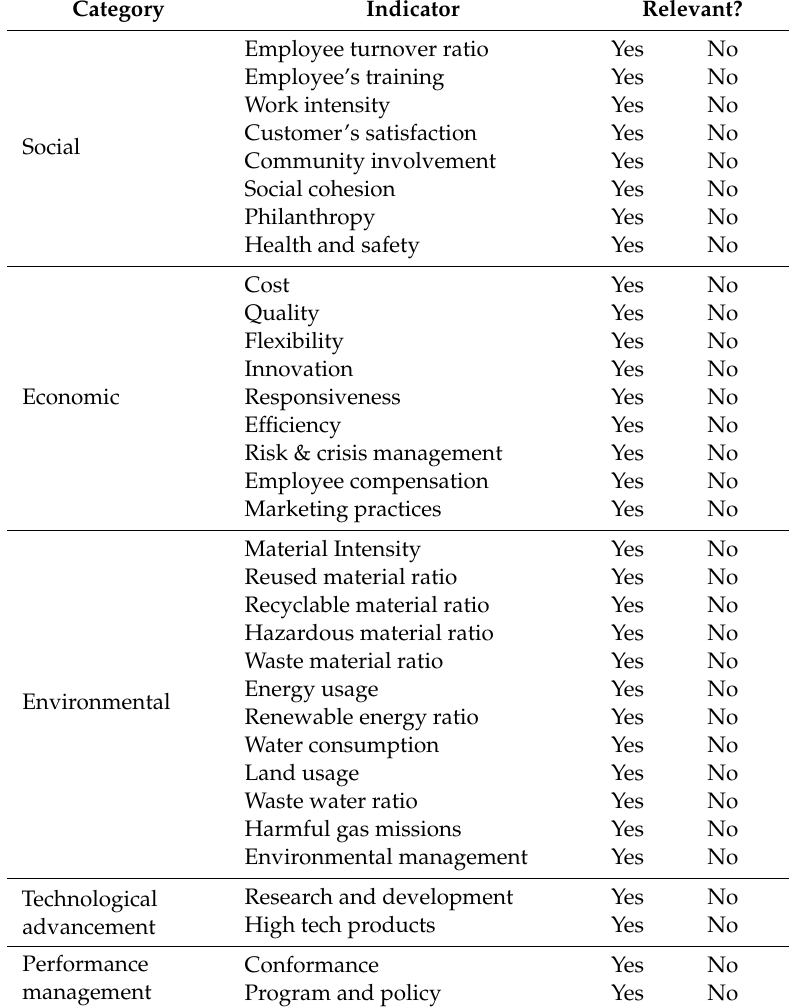
Table 3. List of indicators for the assessment of sustainability in a specific manufacturing company.